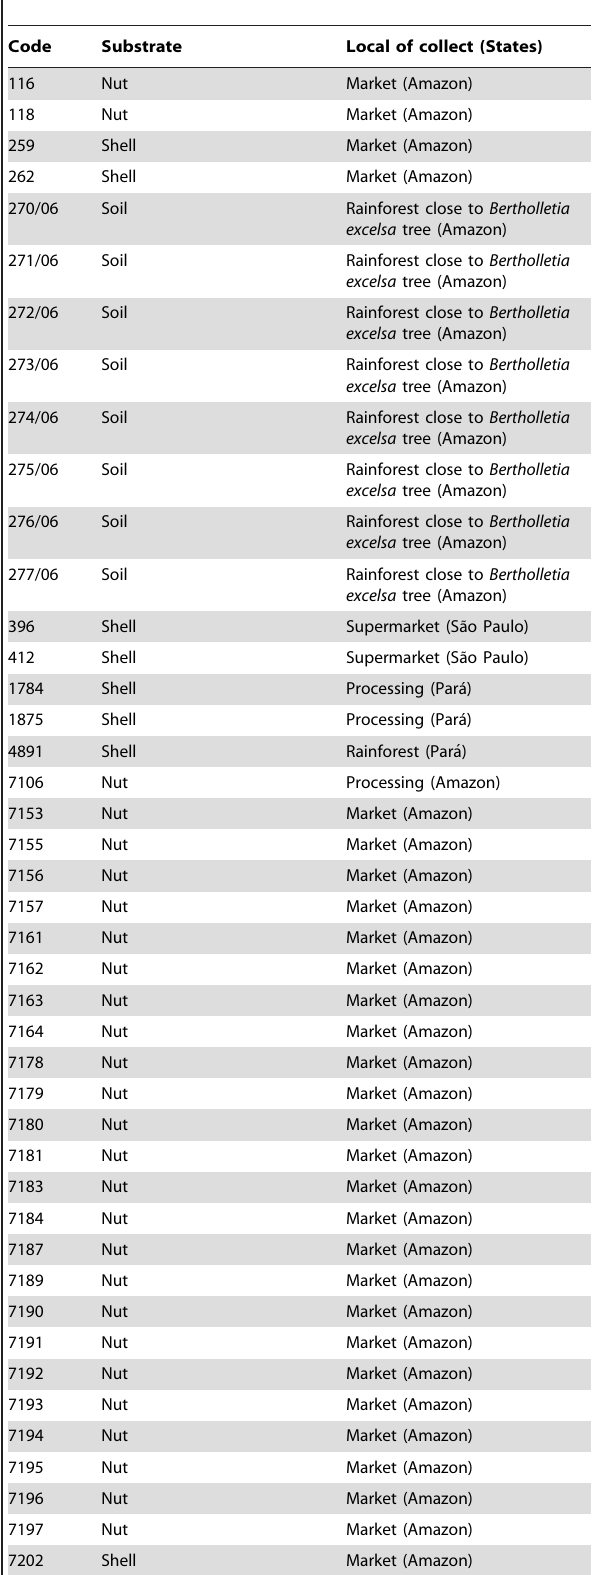
Table 1. Aspergillus bertholletius isolates from brazil nuts (nuts and shell) and soil from Amazonian rainforest.